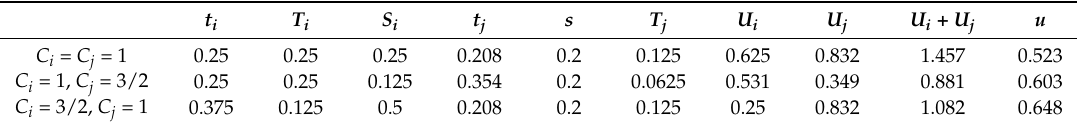
Table 2. Values of variables for various parameter